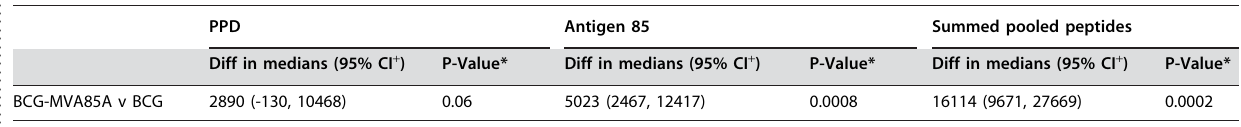
Table 6. Comparison of area under the curve analysis for BCG alone and BCG–MVA85A .. ... .... ... ... .... ... ... .... ... ... .... ... ... .... ... ... .... ... ... .... ... ... .... ... ... .... ... ... .... ... ... .... ... ... .... ... ... .... ... ... .... ... ... .